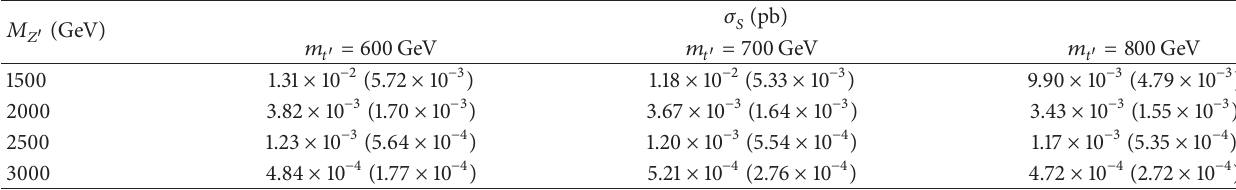
Table 8: The same as Table 7, but for 𝑥 = 0.05